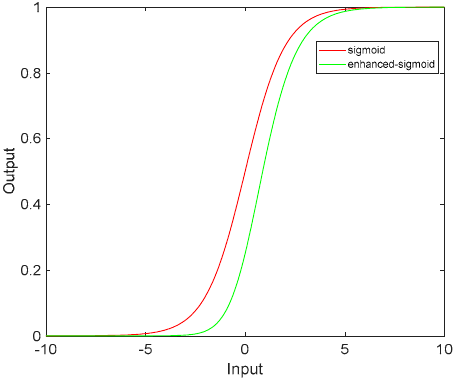
Figure 5. Comparison between the sigmoid function and the enhanced-sigmoid function.